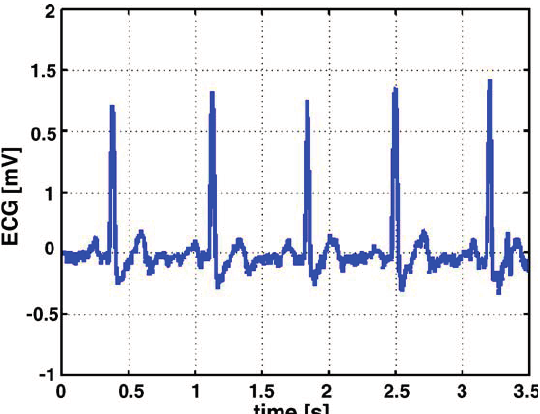
Figure 5. ECG measured with conventional electrodes (in the same setup of the belt prototype in Figure 3) [31]. Copyright © 2005 Elsevier